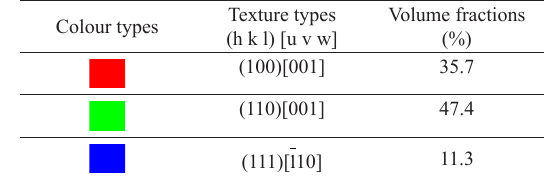
Table 2. Fraction of common textures in region 3.